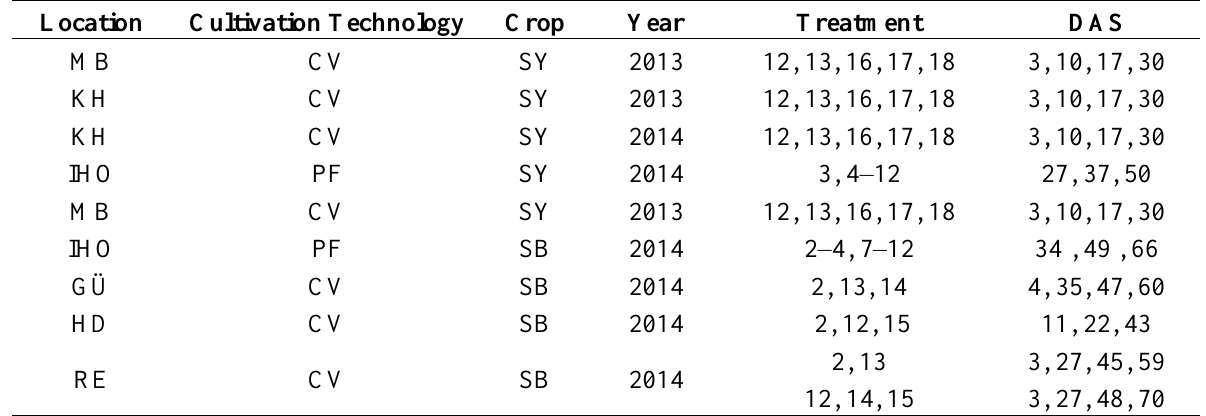
Table 2. Selection of treatments and timings for treatments (DAS = Days after sowing) in soybean (SY) and sugar beet (SB) experiments at locations Ihinger Hof (IHO), Gützingen (GÜ), Heidfeldhof (HD), Renningen (RE), Kleinhohenheim (KH) and March-Buchheim (MB); (PF = Precision Farming; CV = Conventional Farming). Location Cultivation Technology